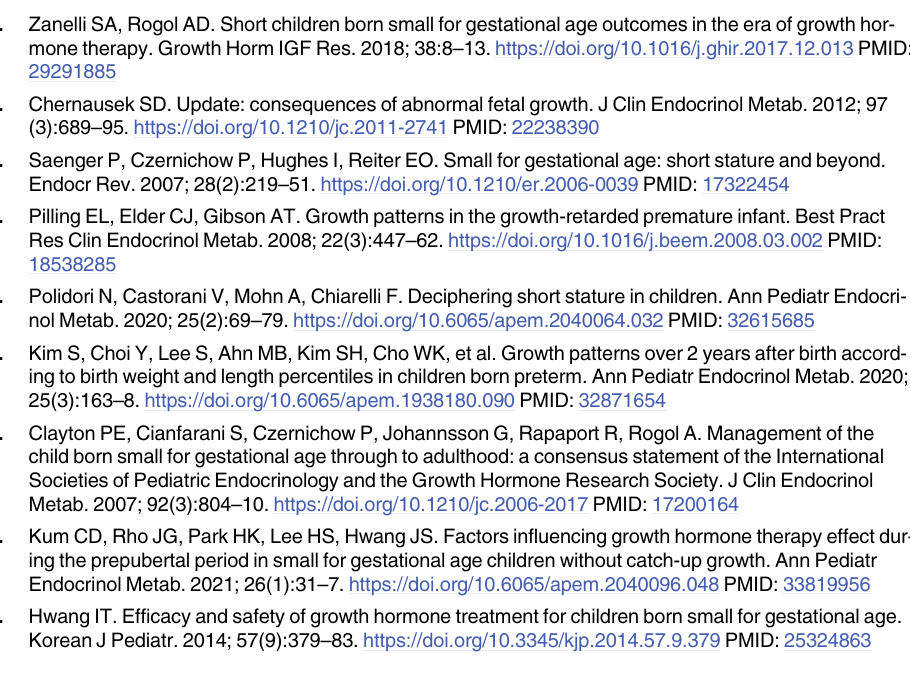
S3 Table. Baseline characteristics in patients with SGA based on pubertal status. S4 Table. Baseline characteristics in SGA patients based on gestational